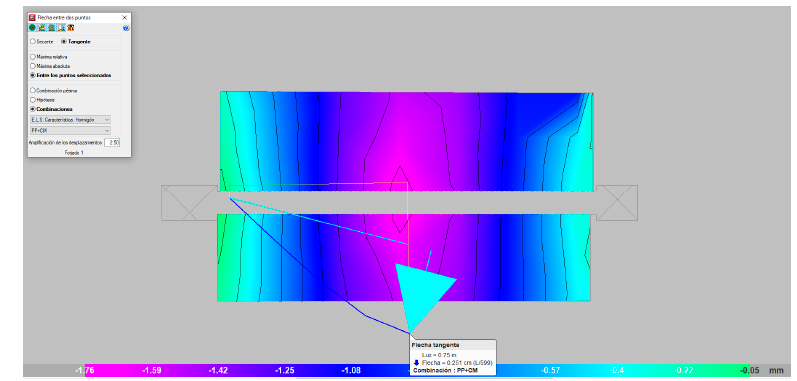
Figure 16. Deformation under the maximum load (mm).